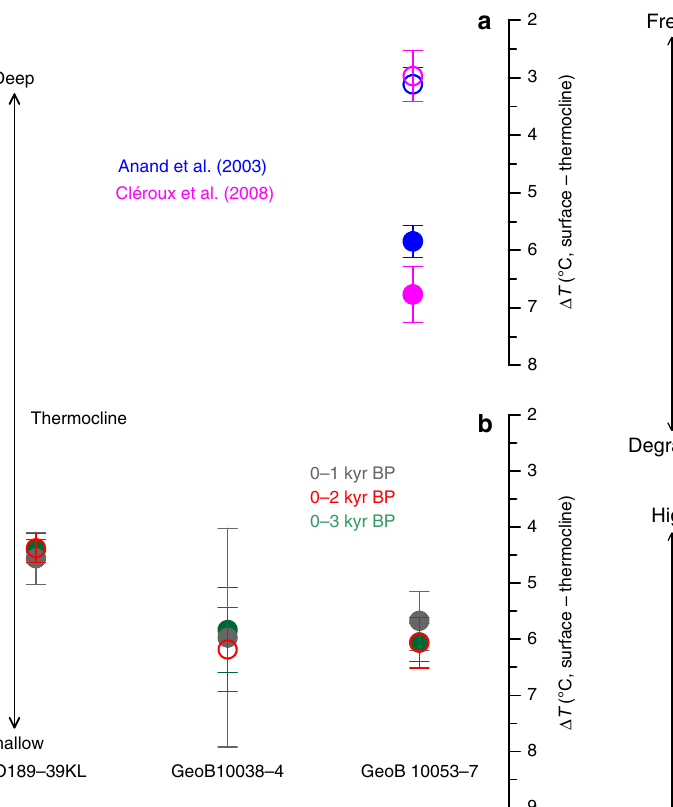
Fig. 2 Comparison between different temperature calibrations and late Holocene intervals. a Difference between average surface and thermocline temperatures ( Δ T ) for the late Holocene ( fi lled circles ) and the LGM ( open circles ) using two different temperature calibrations for P. obliquiloculata 42, 48 indicated by different colours. Vertical bars represent 95% con fi dence interval based on t -distributed samples in each time interval. b Average late Holocene difference between surface temperatures derived from Mg/Ca values in G. ruber and thermocline temperatures derived from Mg/Ca values in P. obliquiloculata . Grey circles ( fi lled ) represent Δ T for the past 1000 years, red circles ( open ) for the past 2000 years and green circles ( fi lled ) for the past 3000 years. Vertical bars indicate 95% con fi dence interval based on t -distributed samples in each time interval. Note that the values remain similar regardless of the considered period